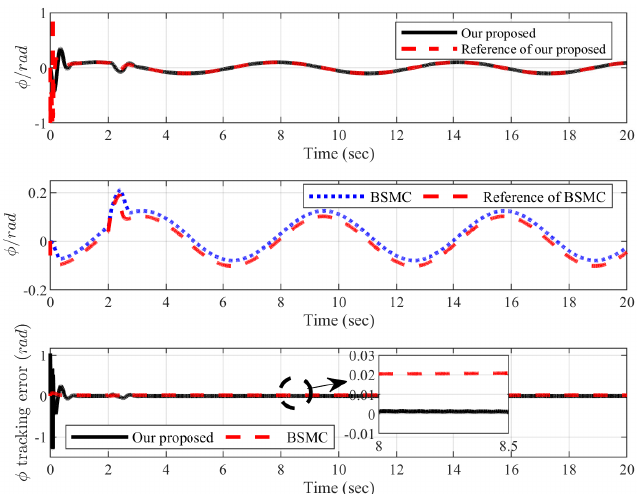
Figure 9. The control performance and tracking errors in relation to the roll angle.